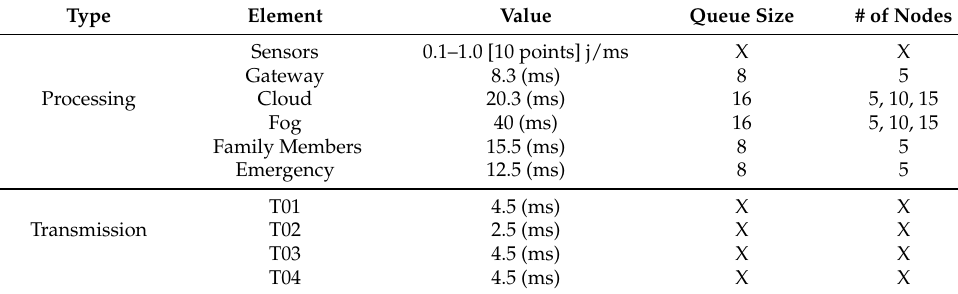
Table 2. Model configuration parameters for numerical analysis.